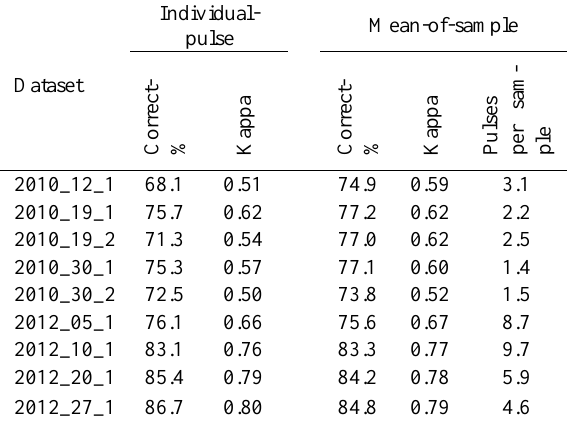
Table 2. Overall classification accuracy (%) and kappa in LDA classification of four vegetation types. Features used were the peak amplitude and total echo